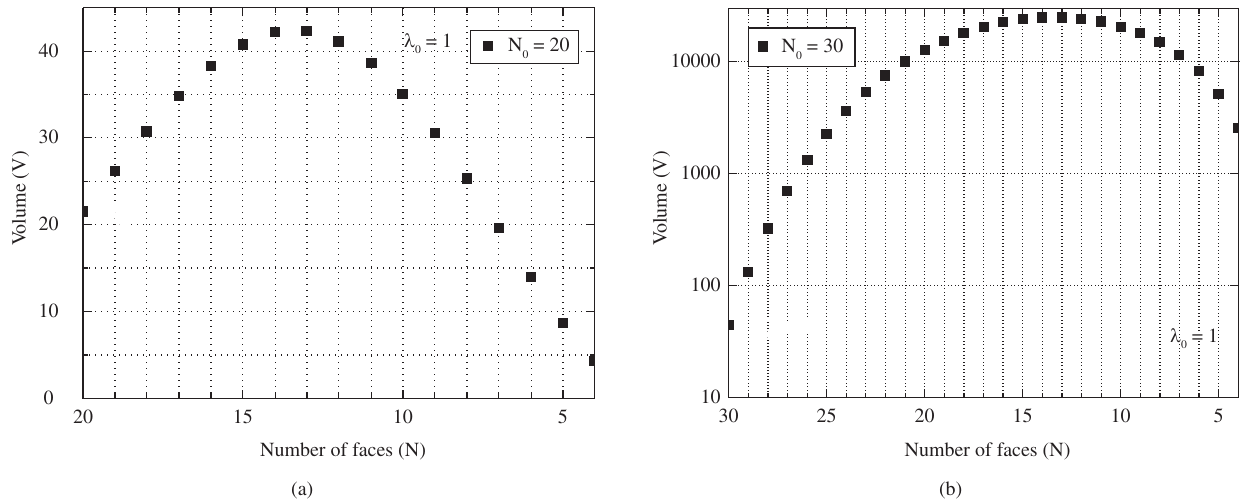
Figure 4. Grain trajectories in (N,V) space: a) N start to